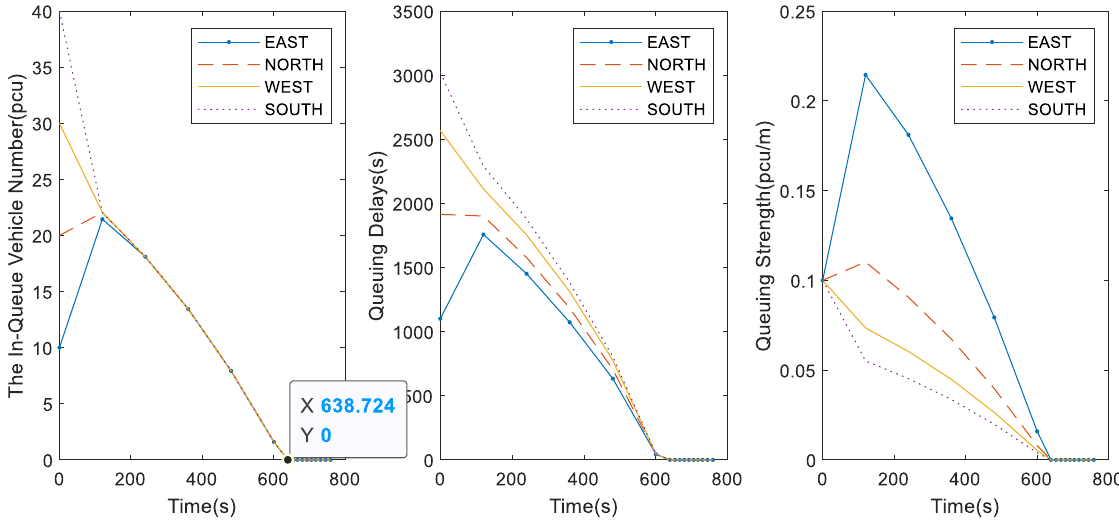
Figure 2. The queuing index of the game equilibrium algorithm in this paper.